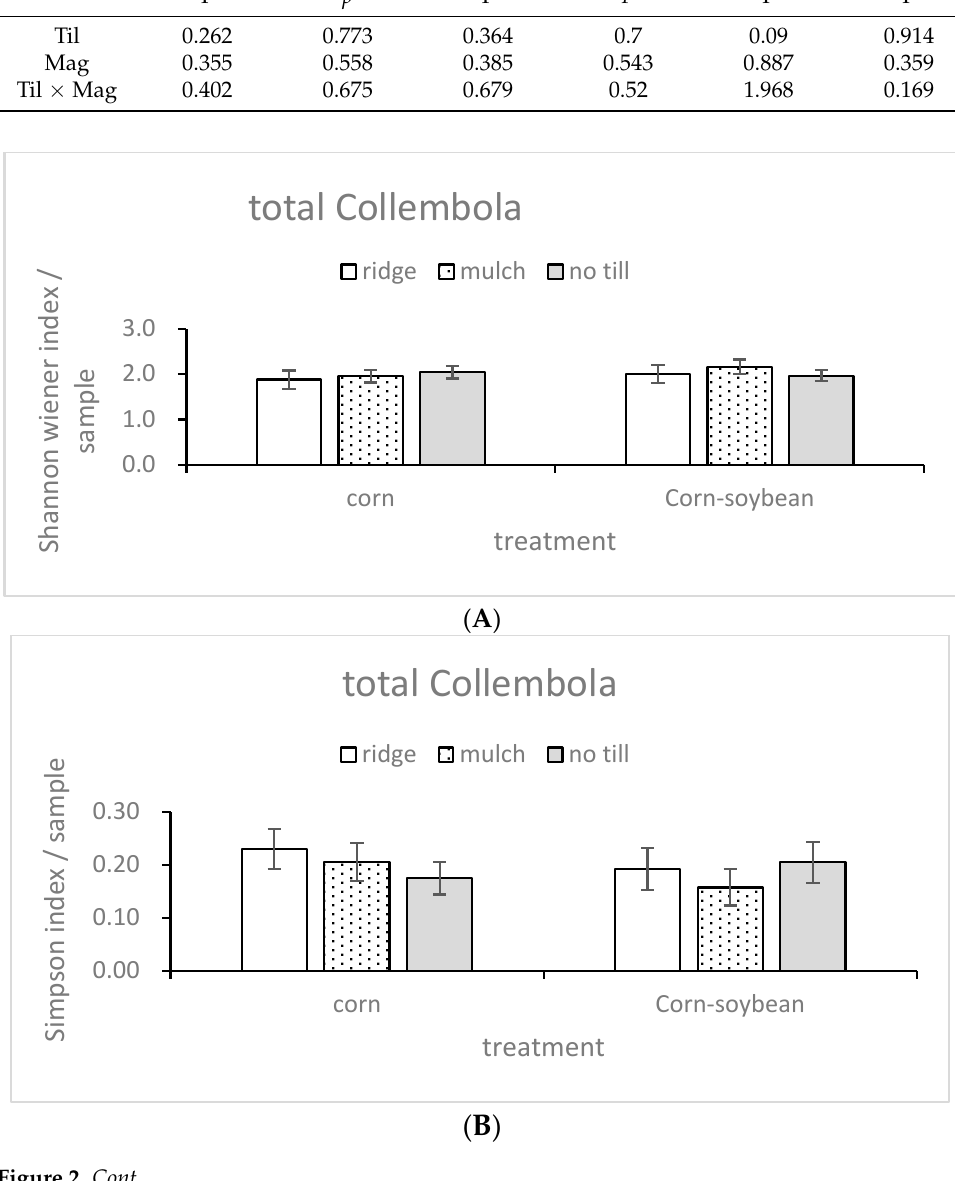
Table 2. Results of analysis of variance (ANOVA) of the effects of tillage type and crop rotation on the Shanon index, Simpson index, and Pielou index of Collembola communities. Factors Figure 1. Analysis of variance (ANOVA) barplot of the treatments data showing ( A ) abundance of strong furca ( B ) specie richness of strong furca ( C ) abundance of weak furca ( D ) specie richness of weak furca across three tillage types are differentiated by capitalized letters (A, B, AB) and across corn, and corn–soybean rotation is differentiated by lower case letters (a, b) Superscripts indicate significant differences between factors at the 0.05 level.